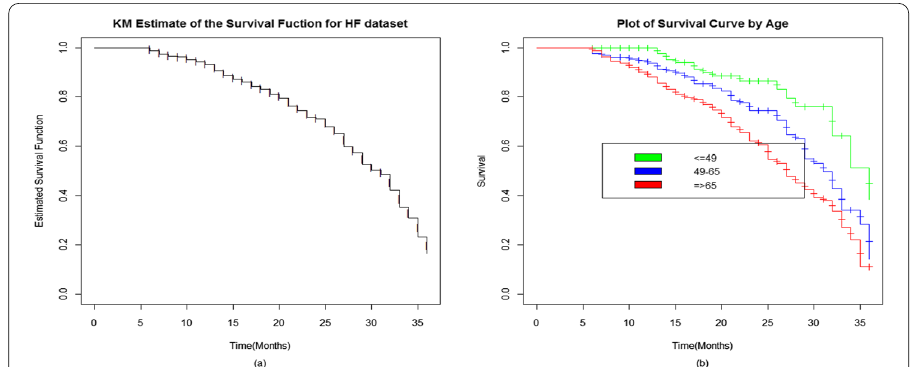
Fig. 1 Kaplan–Meier estimates of the survival curves of HF data set for ( a ): Overall survivor function for heart failure patients in the study, ( b ): Age group